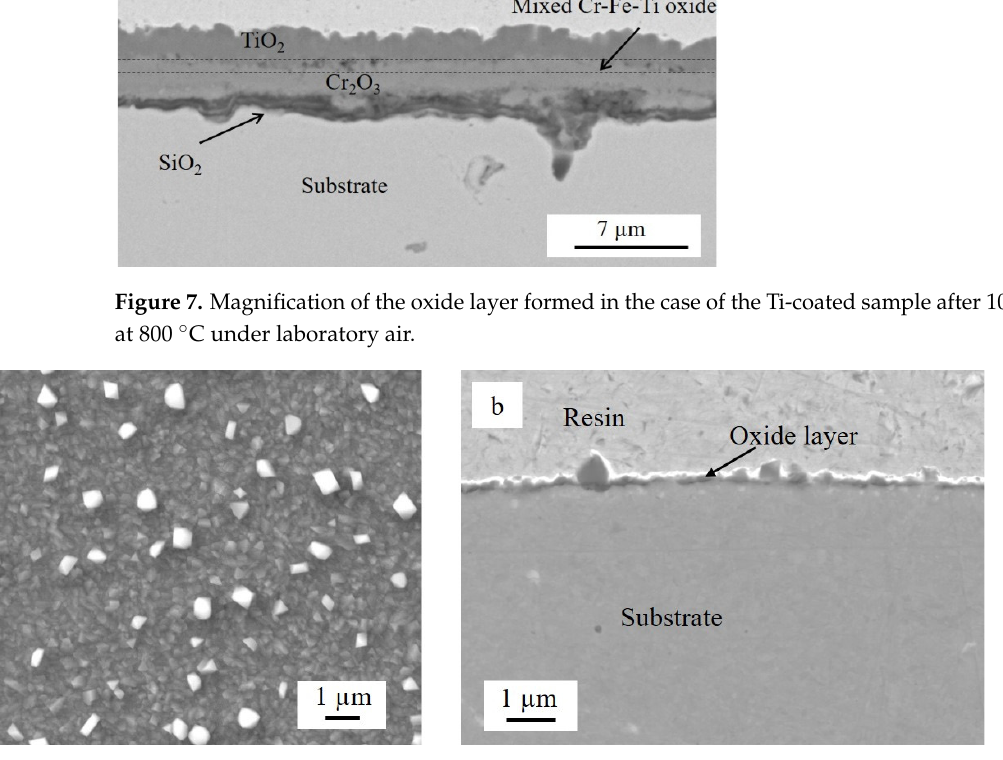
Figure 8. Backscattered electron image of the steel substrate after 1 h of pre-oxidation at 800 °C in ambient air: ( a ) surface and ( b ) cross section.